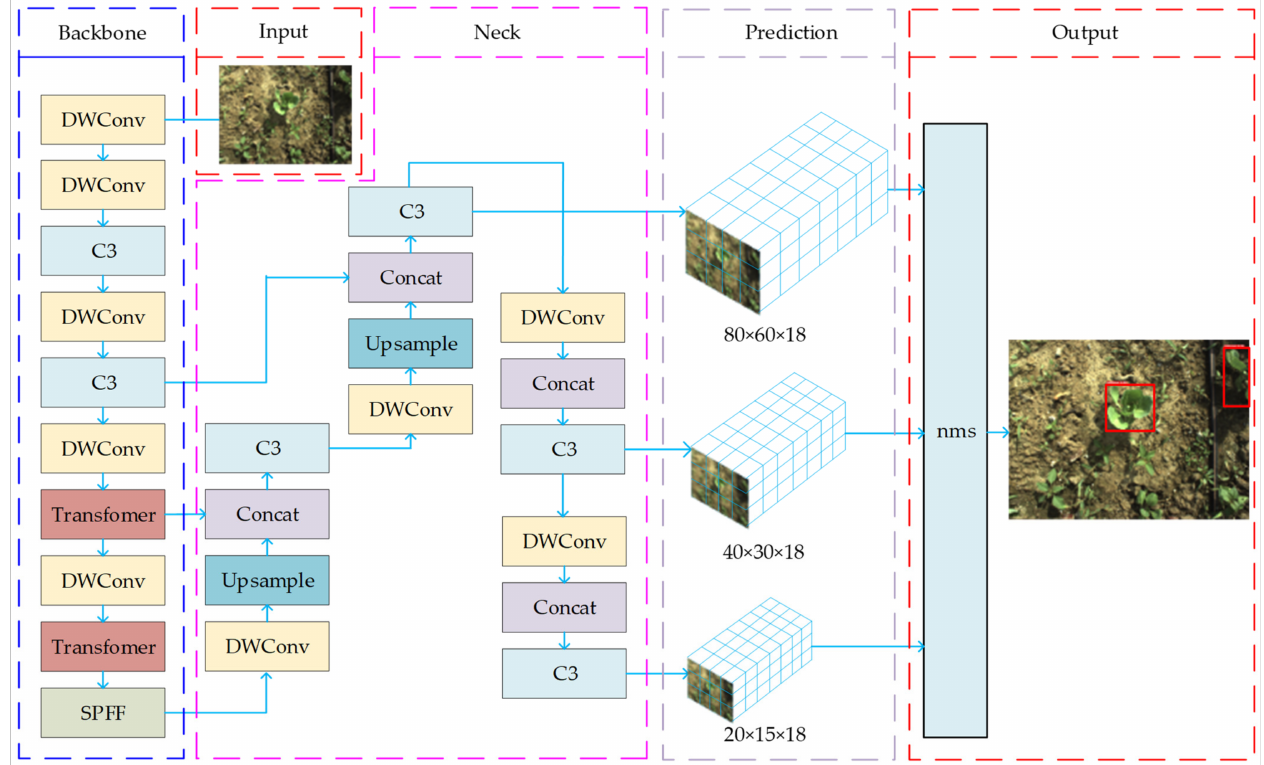
Figure 2. Structure of the cabbage detection model.